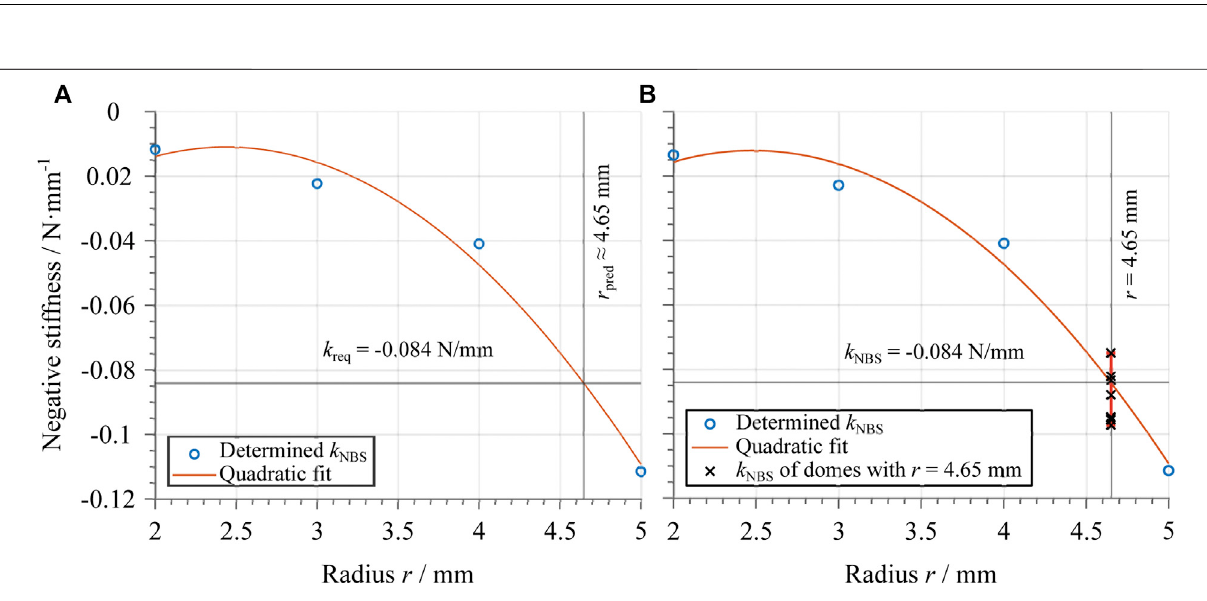
Frontiers in Robotics and AI |